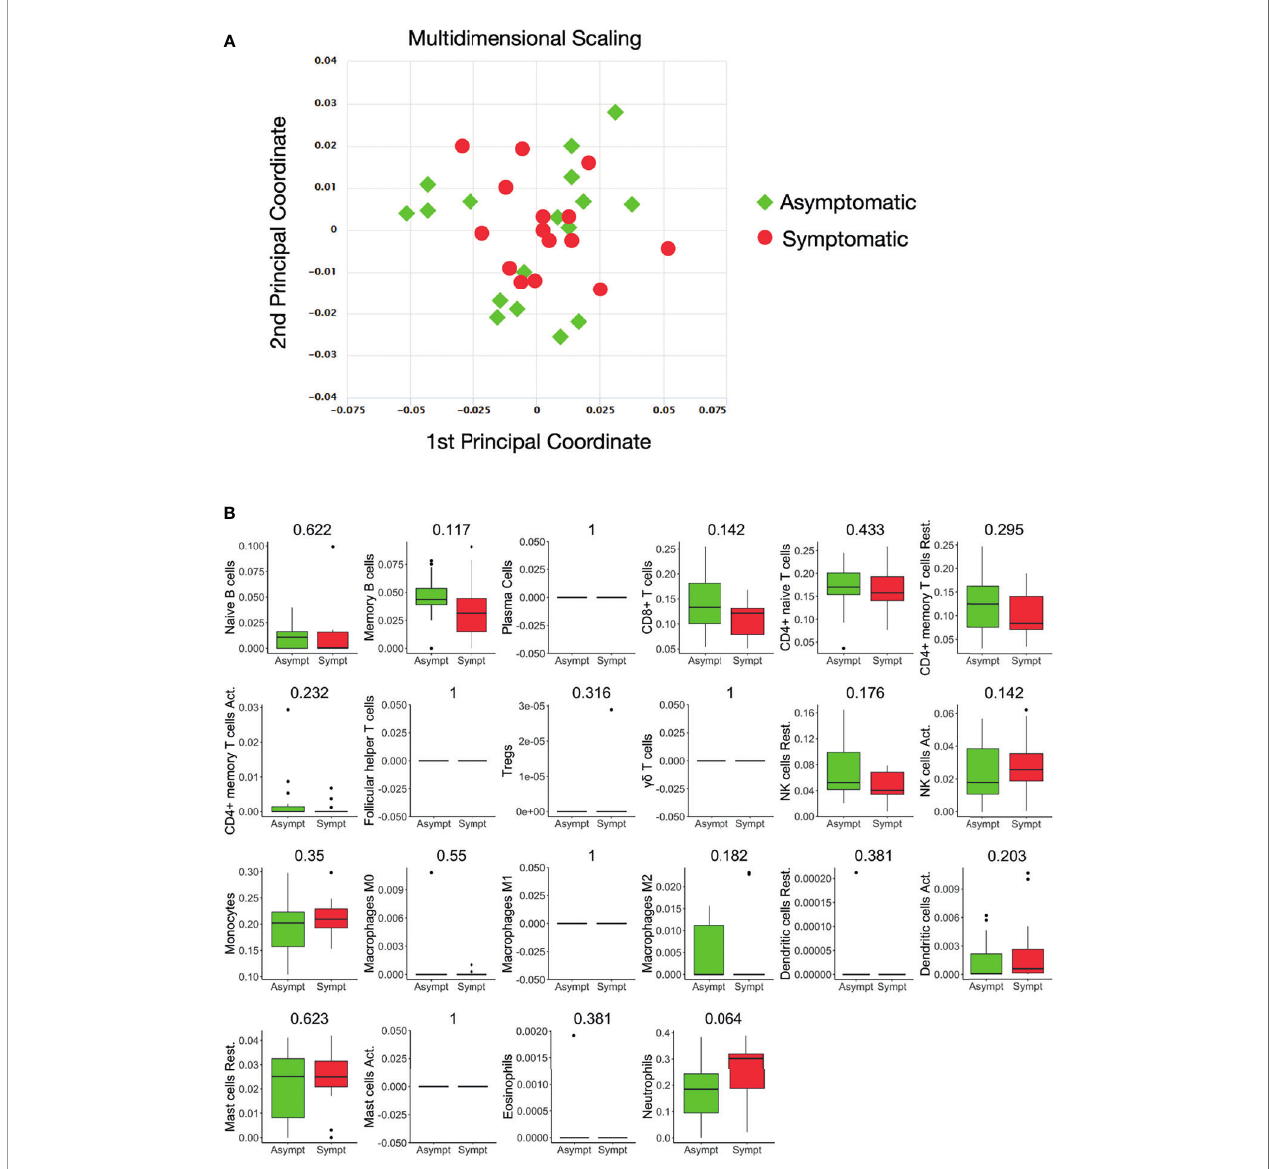
FIGURE 1 | Whole blood transcriptional pro fi les and immune cell subsets in seropositive healthy individuals with prior asymptomatic or clinical SARS-CoV-2 infection. (A) Dimensionality reduction of all samples: Multidimensional scaling of all samples from individuals with prior clinical (n=15) and prior asymptomatic (n=17) infection. Each dot corresponds to the sample of one individual. All expressed elements were used (16.737, out of which 12.789 were non-zero protein-coding genes), in order to avoid gene type biases. The smaller the distance between each sample pair, the greater the similarity of the gene expression pro fi le of the samples. No separation of the two sample groups is revealed, re fl ecting their similarity. (B) Blood transcriptome deconvolution with CYBERSORTx in prior asymptomatic (AS) and prior clinical (CL) disease groups. For every cell type, the Mann-Whitney U test p-value comparing the two groups is displayed on top. No statistically signi fi can differences (meta p-value< 0.05) were detected between the two